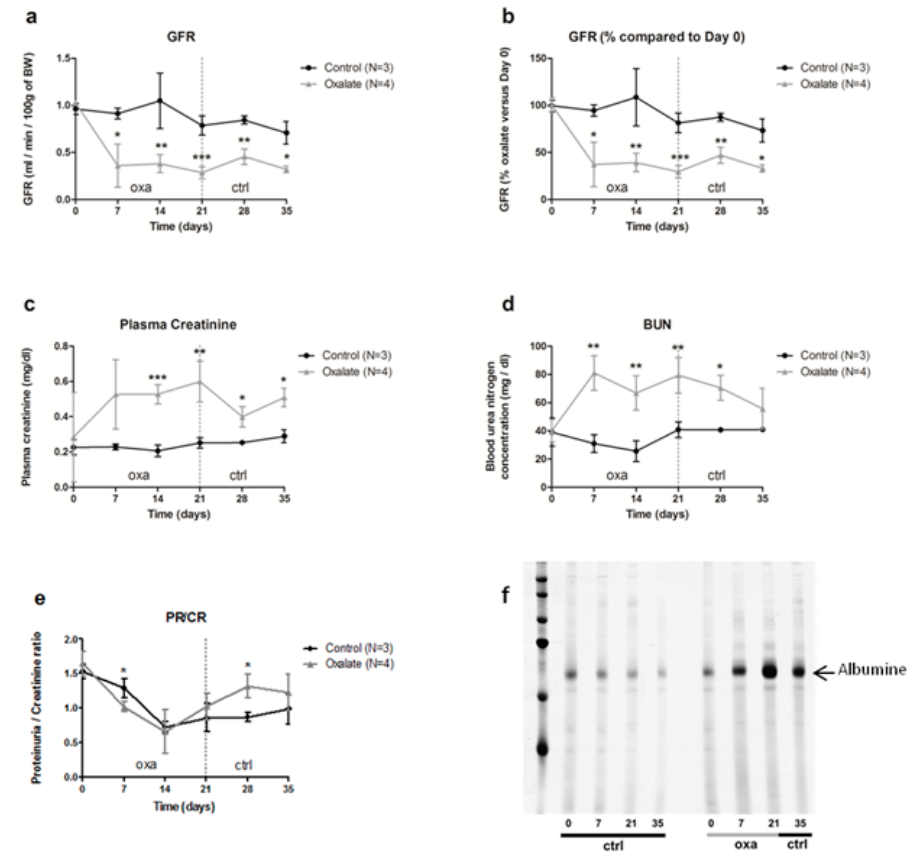
Figure 2. Impact of the 5-week regimen (3 weeks of OXA diet + 2 weeks of control diet) on kidney function: ( a ) glomerular filtration rate (mL/min/100 g of body weight); ( b ): percentage of GFR compared to day 0 of the diet (%); ( c ) plasma creatinine concentration (mg/dL); ( d ) blood urea nitrogen concentration (mg/dL); ( e ) ratio total protein/creatinine concentration (mg/24-h/100 g of body weight); ( f ) profile of urinary proteins excreted by ctrl and oxa rats. The 24 h urine samples were subjected to 10% SDS-PAGE. Following electrophoresis, the gels were silver stained using the ProteoSilver Plus Kit (Sigma-Aldrich). Results are expressed as mean ± SD. * p ≤ 0.05; ** p ≤ 0.01; *** p ≤ 0.001, versus control. Control n = 3, oxalate n = 4.